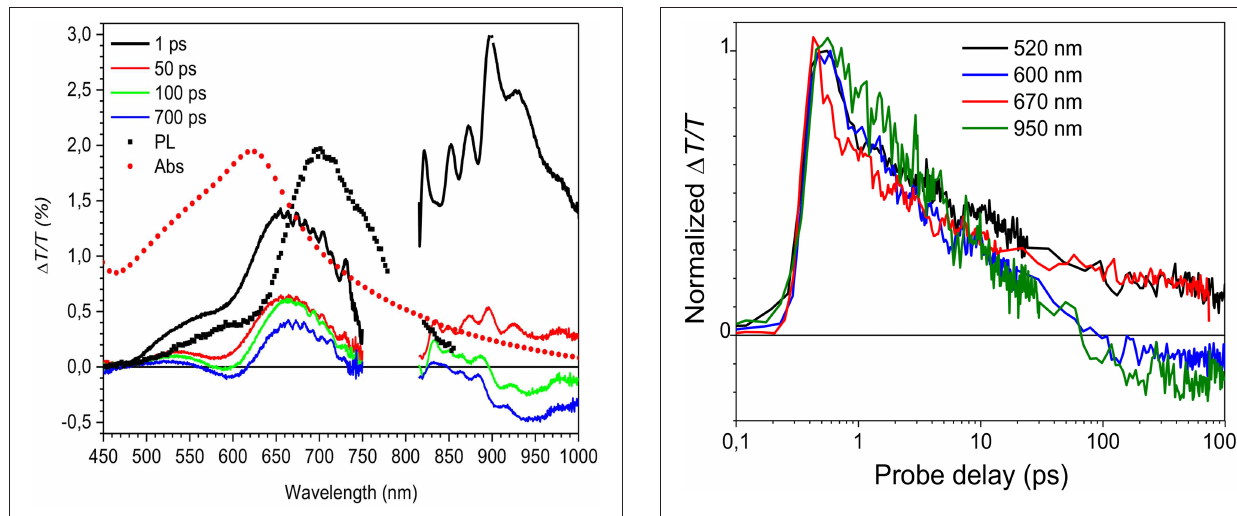
FIGURE 6 | 1 T / T spectra at different probe delays (see legend in the figure) compared to the absorption (Abs, red solid circles) and photoluminescence (PL) emission (black solid squares) spectra for the LMM mesoparticle suspension.